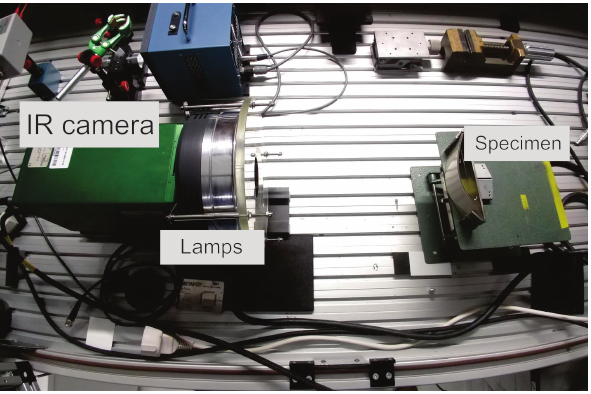
Figure 3. Reflection mode PT set-up used in this